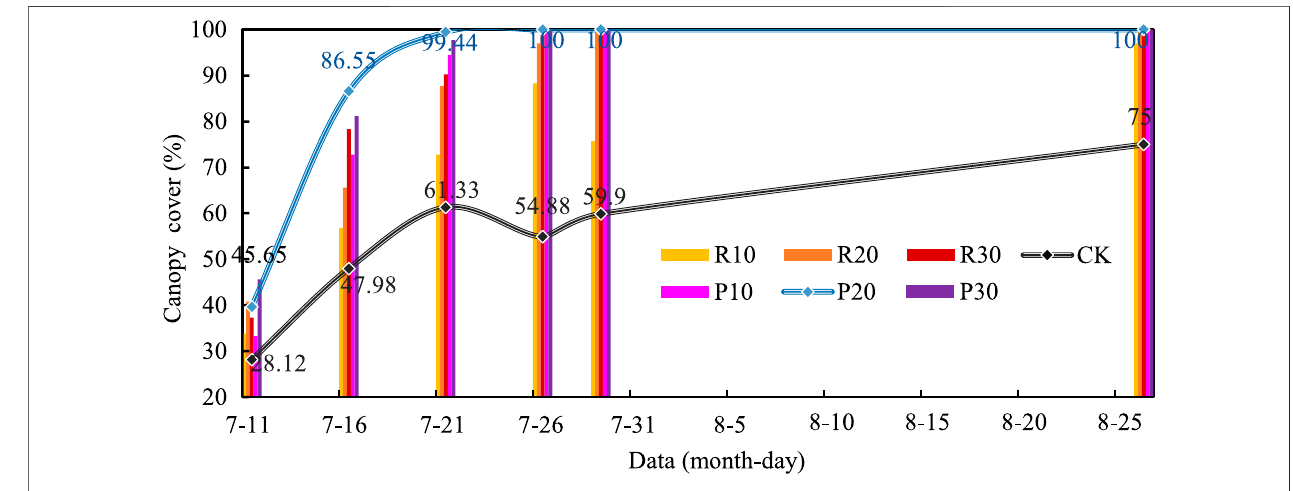
FIGURE 9 | Variations of the alfalfa canopy cover under different irrigation treatments during the study period based on RGB images.